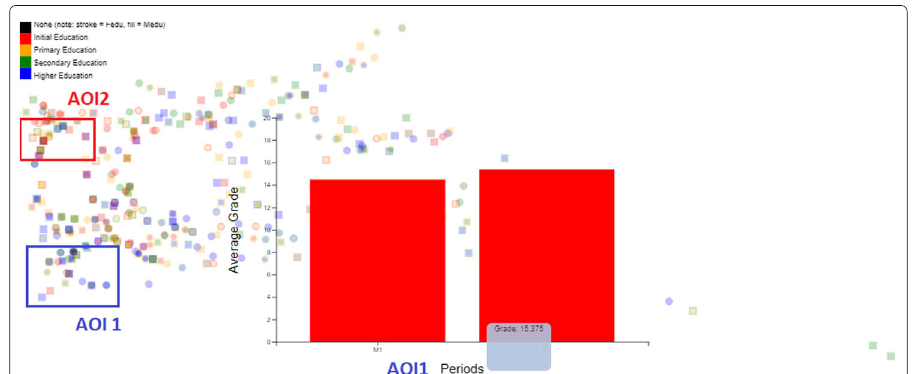
Fig. 21 Isomap for "Mathematics" class, period 1, considering both